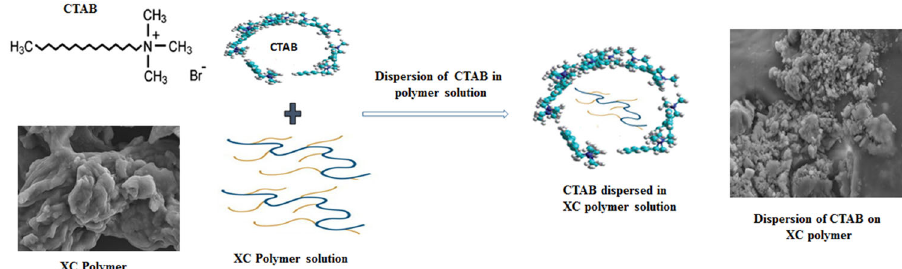
Fig. 13 Dispersion of CTAB